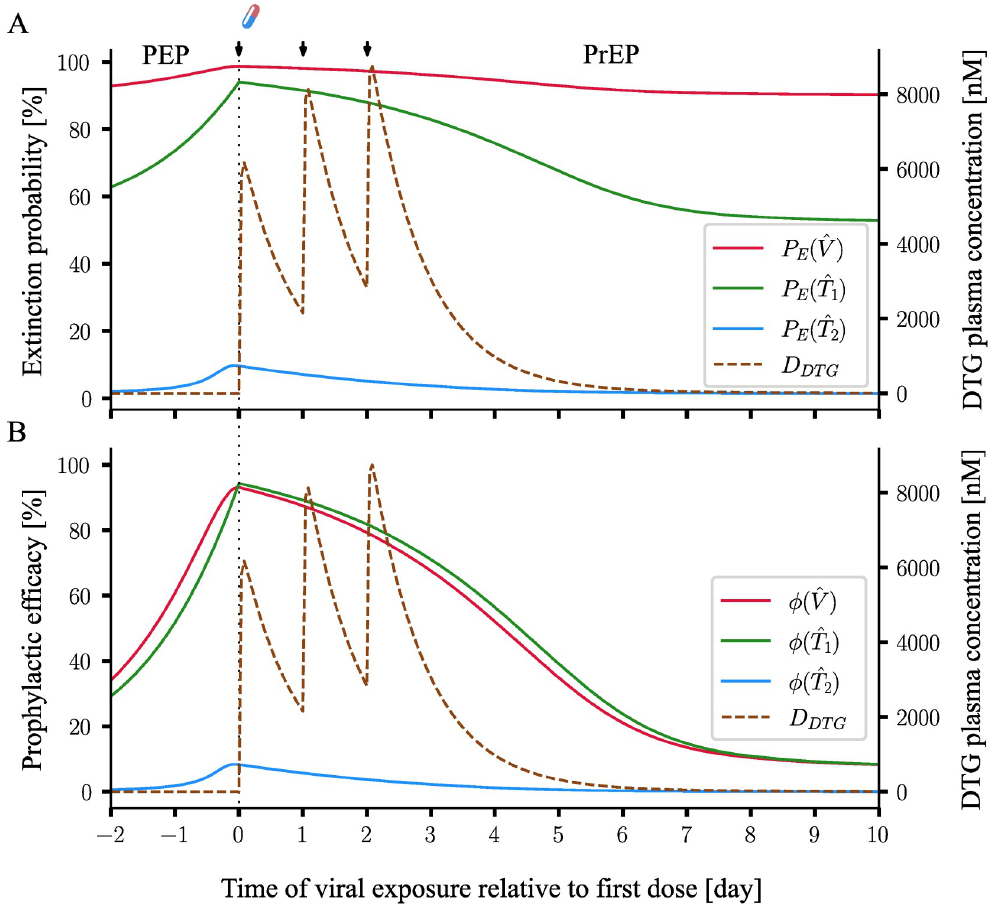
Fig 3. Prophylactic efficacy for 3-days once daily short-course oral 50mg DTG. The extinction probabilities were computed by PGS, for a representative individual with pharmacokinetic parameters k 0.0082 L/h, CL / F bio = 0.85 L/h and V c / F bio = 17.7 L. Observation began from two days before the first dose (the drug-doses are marked by arrows), until the 10th day after the first dose of DTG. The X-axis denotes the timing of viral exposure relative to the first dose, i.e. negative values represent a viral exposure before the first dose of DTG (post-exposure prophylaxis, PEP), whereas positive values represent pre-exposure prophylaxis (PrEP) scenarios. A . DTG plasma concentration (dashed brown line) and the extinction probability profiles, with regards to one virus P ð ^ T ; S Þ are shown by solid red, green and blue lines. B . DTG plasma concentration (dashed brown line) and the P 2 E corresponding prophylactic efficacies for one virus φ ð ^ V ; S Þ , one T 1 -cell φ ð ^ T solid red, green and blue